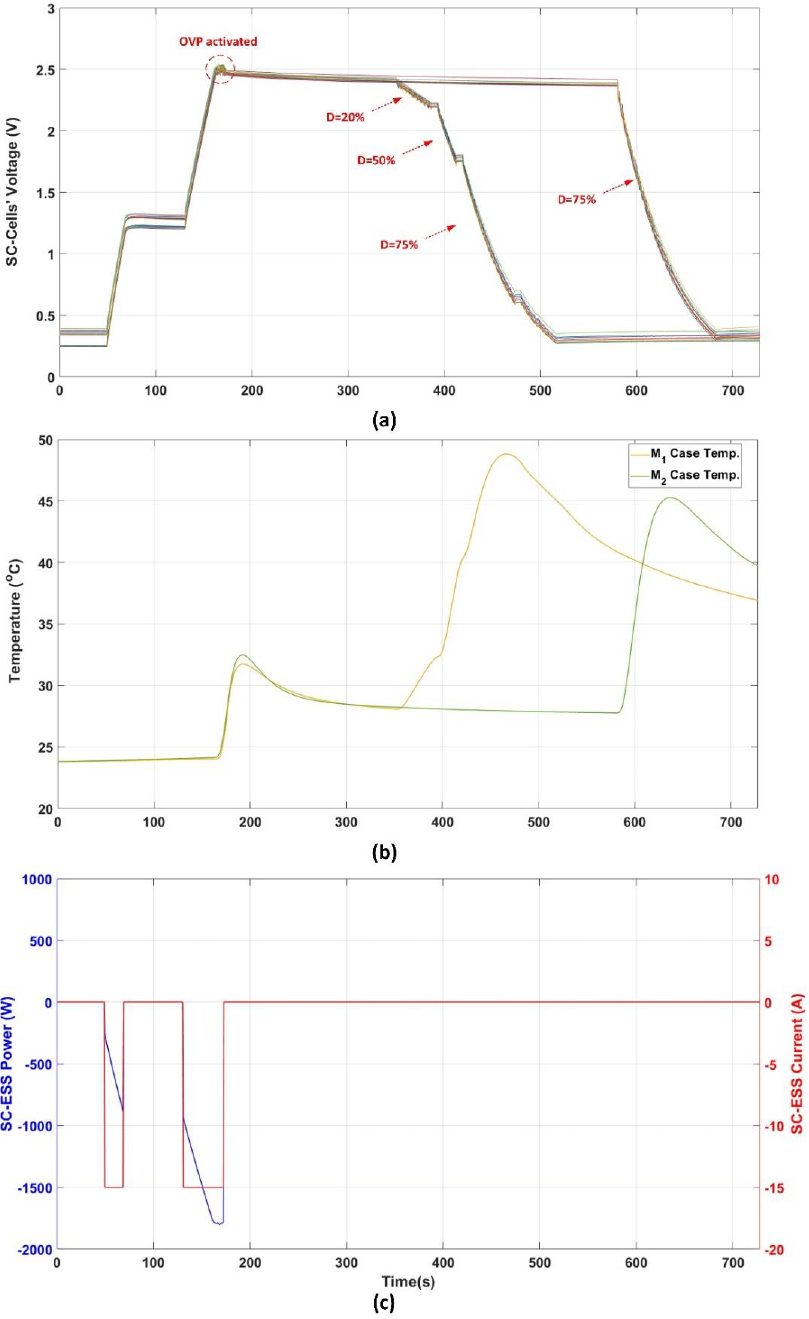
Figure 10. Performing of protective action to protect the SC cells by OVP subsystem during charge/discharge as well as responding to discharge commands from the central controller: ( a ) SC cells ’ voltages; ( b ) SC-modules 1 and 2 enclosures’ temperatures; ( c ) Discharge power and current. The third test reported in Figure 11 evaluates the capability of the OVP subsystem to perform active dissipative SC cells’ voltage balancing as a preventive action to protect the cells from overvoltage. The test started with imposed mismatching between the SC cells, then a discharging process by a constant power of 1.3 kW was introduced at t = 15 until t